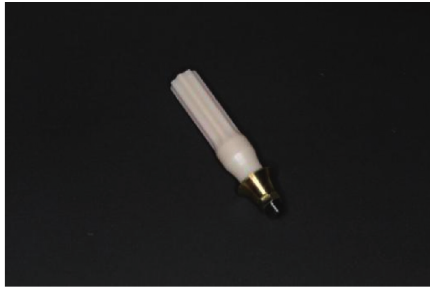
Figure 3: Removable On1 platform switching